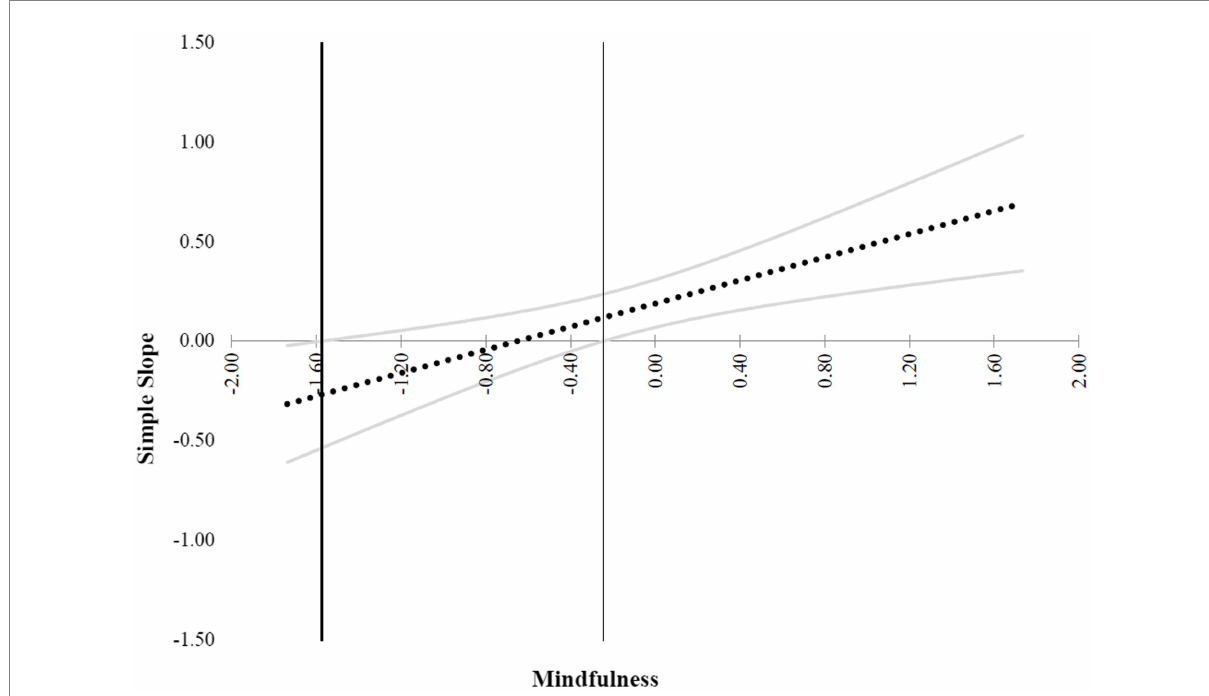
FIGURE 4 Regions of significance. Simple slope of workplace event criticality predicting work engagement by employee mindfulness. This figure presents the simple slope ( Y -axis) across different scores of employee mindfulness ( X -axis). Employee mindfulness was grand-mean-centered. Workplace event criticality positively predicts work engagement when the scores of employee mindfulness ≥ −